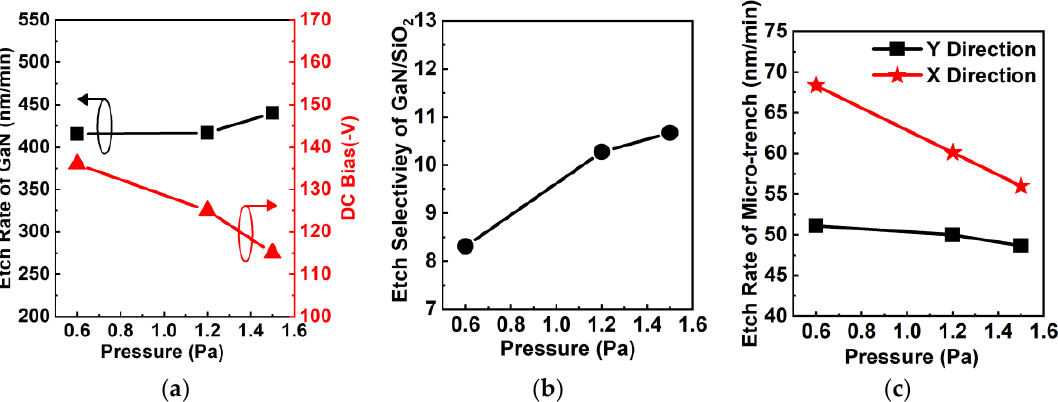
Figure 11. ( a ) Etching rate of GaN and DC bias as a function of pressure. ( b ) Etching selectivity of GaN over SiO 2 as a function of pressure. ( c ) The effect of pressure on etching rates of the microtrench in the X and Y directions.